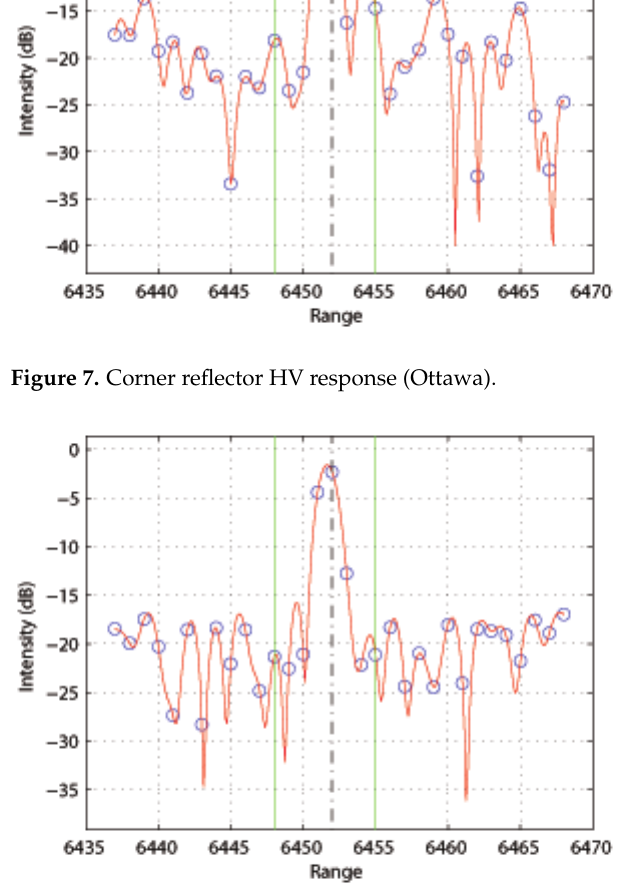
Figure 8. Corner reflector VH response